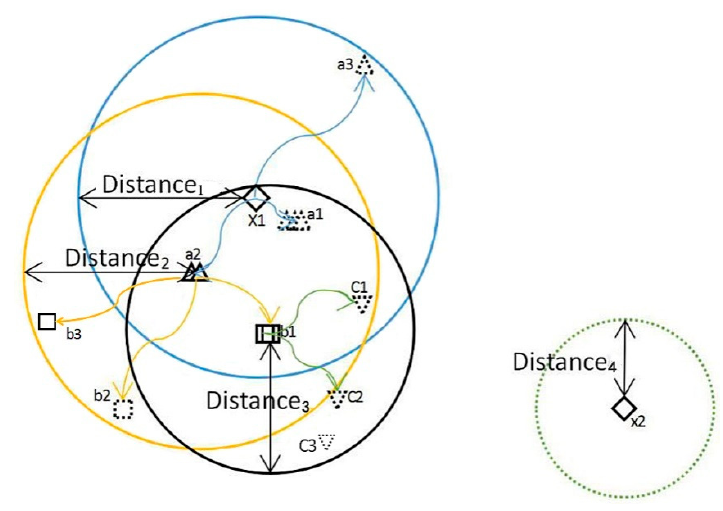
Figure 1. The process of migration and reproduction.